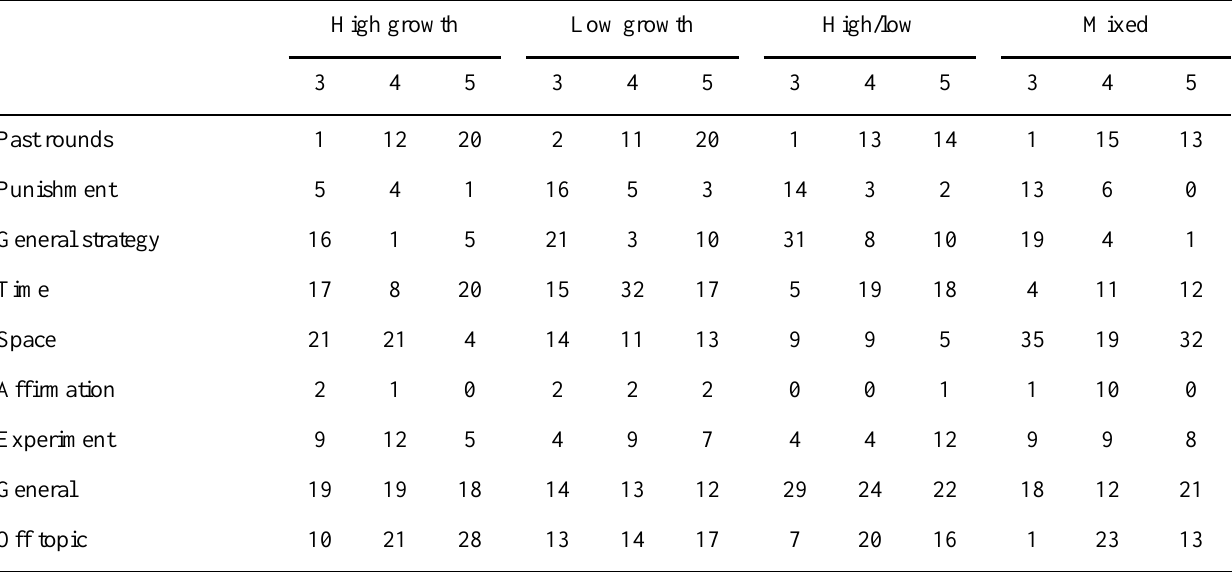
Table 4. The percentage of text messages classified in one of the nine main categories for each treatment and